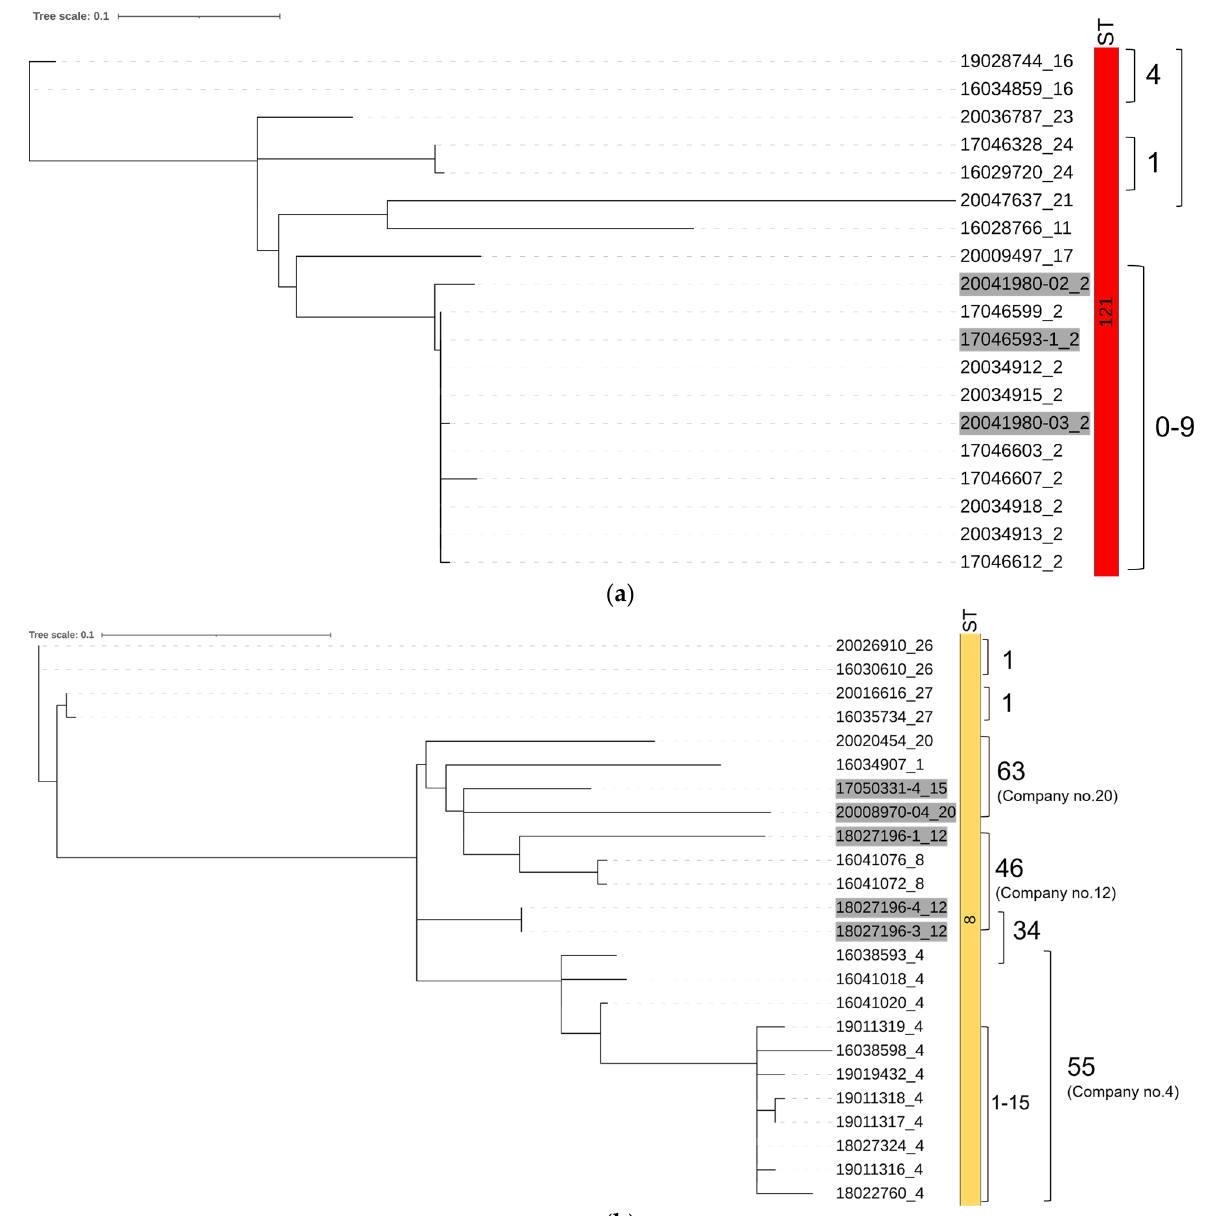
Figure 3. SNP-based phylogenetic trees and SNP-differences of L. monocytogenes isolates belonging to ( a ) ST121 and ( b ) ST8. The first two digits indicate the sampling year (16–20) and the last two digits indicate the company ID; no highlight and grey highlight indicate environmental and product samples, respectively; STs are showed in the right column with colour; and SNP differences between selected isolates are shown as numbers on the right.